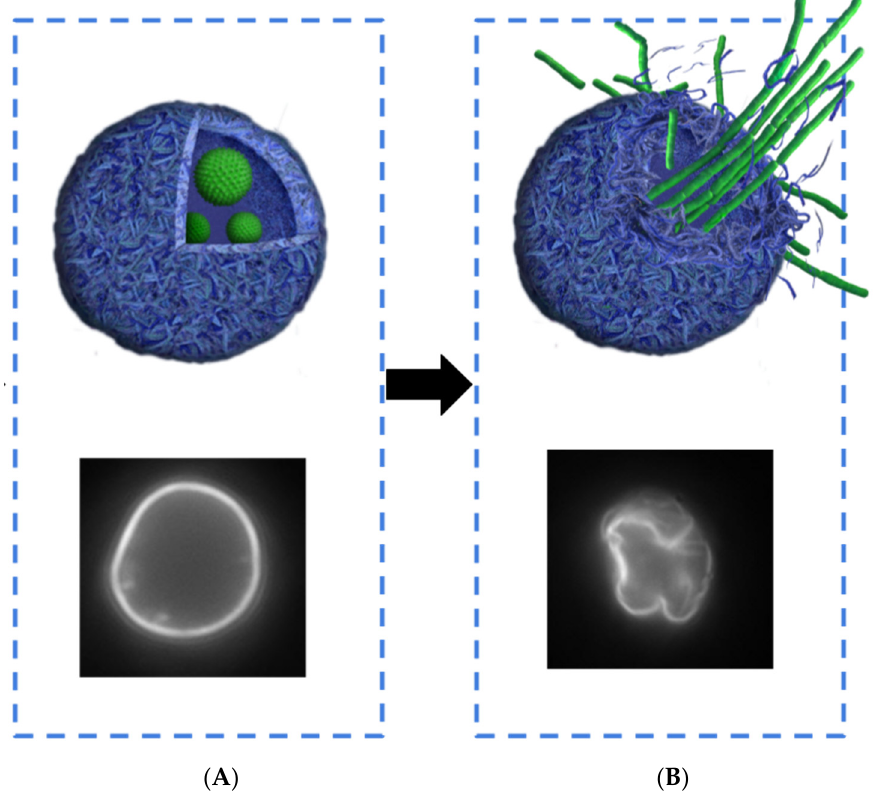
Figure 2. Scheme of bacterially driven decapsulation. ( A )—PMC with encapsulated bacterial spores of Bacillus subtilis ; (B)—release of FITC-dextran and destruction of PMC after spore germination. of Bacillus subtilis ; ( B )—release of FITC-dextran and destruction of PMC after spore